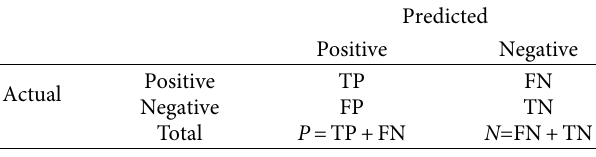
Table 4: Demonstration of the confusion matrix, which is used to detect credit card fraud.